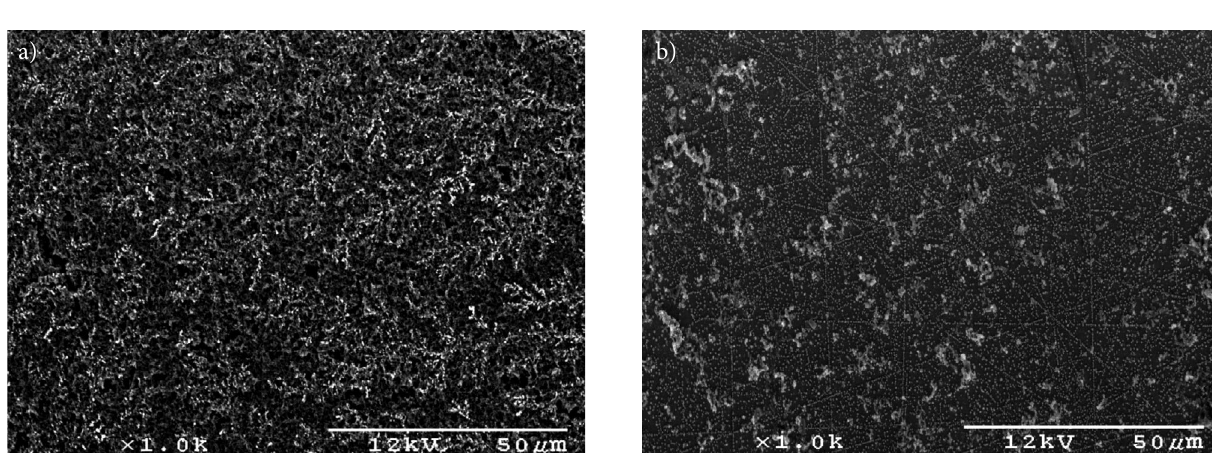
Figure 1 . SEM images of (a) PANI/Pt (b) Au/PANI/Pt electrodes.